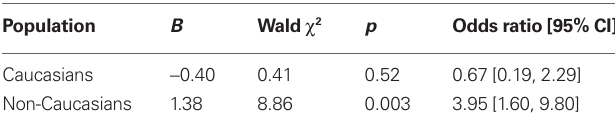
Table 2 | Logistic regressions predicting security of attachment from presence or absence of the A allele at OXTR rs2254298 for Caucasian and non-Caucasian populations.